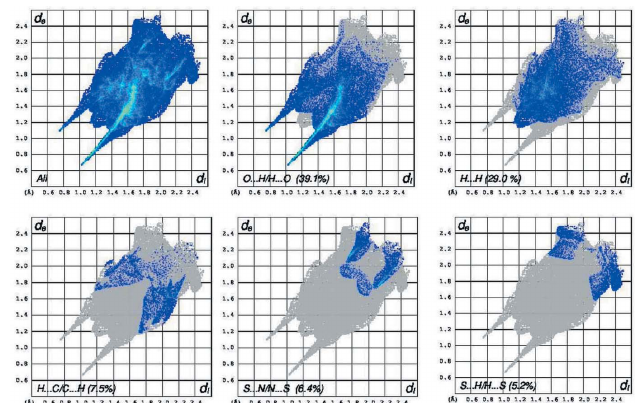
Figure 8 The two-dimensional fingerprint plots for compound (I). The d i and d e values are the closest internal and external distances (in A˚ ) from a given point on the Hirshfeld surface depicted in Fig. 6.